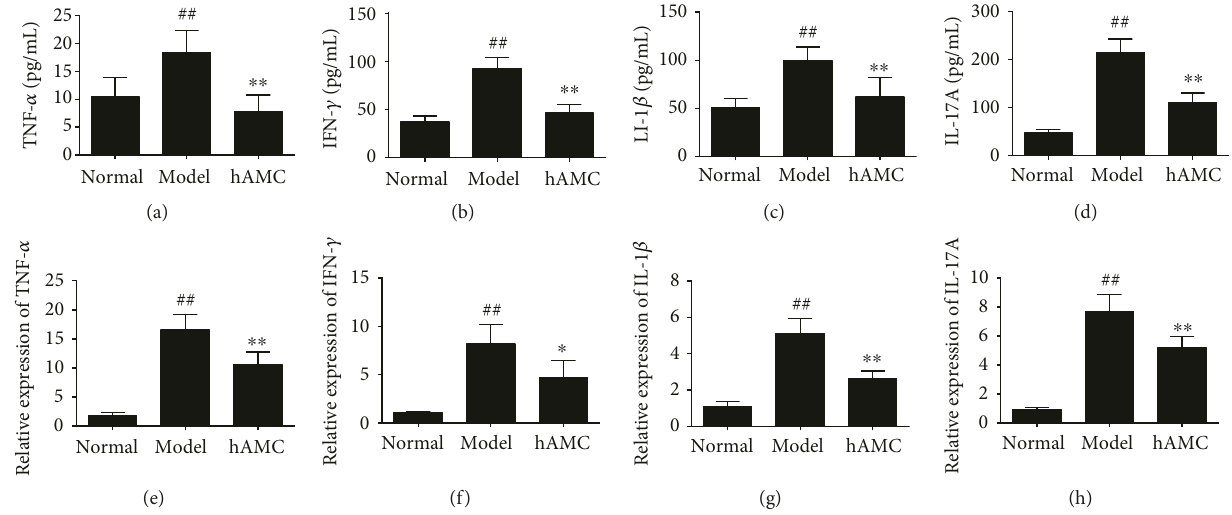
Figure 3: hAMC suppresses the production of proin fl ammatory cytokines in EAE mice. (a – d) E ff ect of hAMC on the production of cytokines in the serum. The levels of TNF- α , IFN- γ , IL-1 β , and IL-17A in the serum of mice were determined by ELISA. (e – h) E ff ect of hAMC on the mRNA levels of cytokines. The mRNA levels of TNF- α , IFN- γ , IL-1 β , and IL-17A in the spinal cords of mice were detected by real-time PCR. Data were mean ± SD. n = 8 mice per group. ## P < 0 01 , compared to normal group. ∗ P < 0 05 , ∗∗ P < 0 01 , compared to model group.